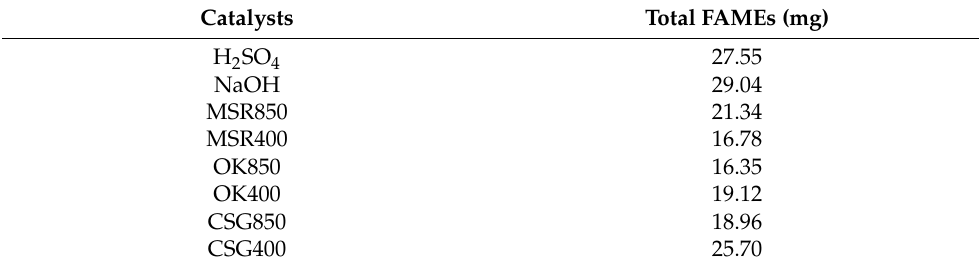
Table 3. Total mass of FAMEs recovered after